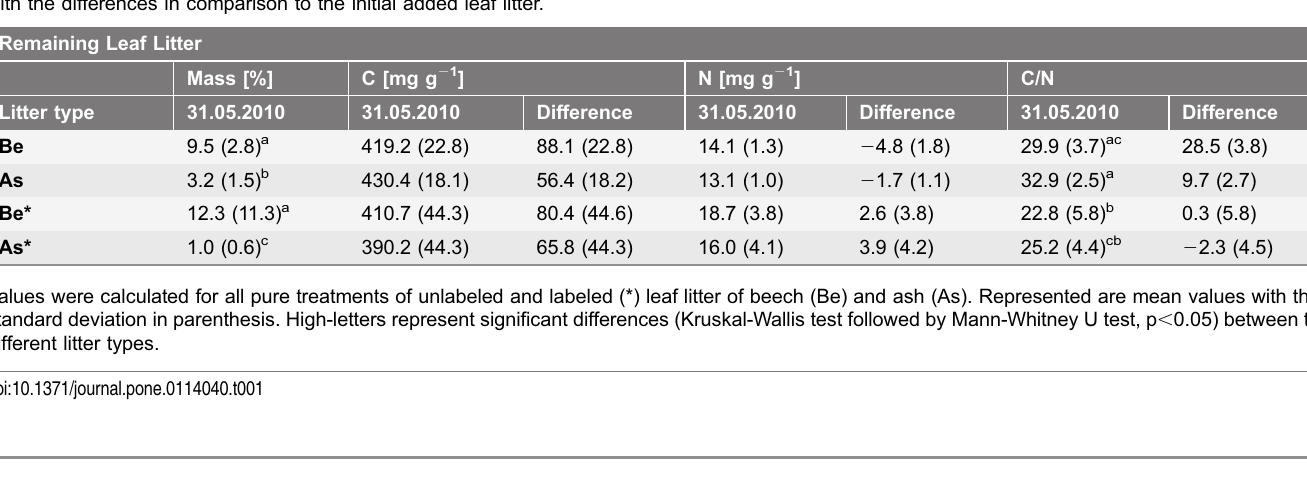
Table 1. Remaining added leaf litter mass [%] with determined C and N concentrations [mg g 2 1 ] and C/N ratios at the end of the experiment (31.05.2010) with the differences in comparison to the initial added leaf litter.